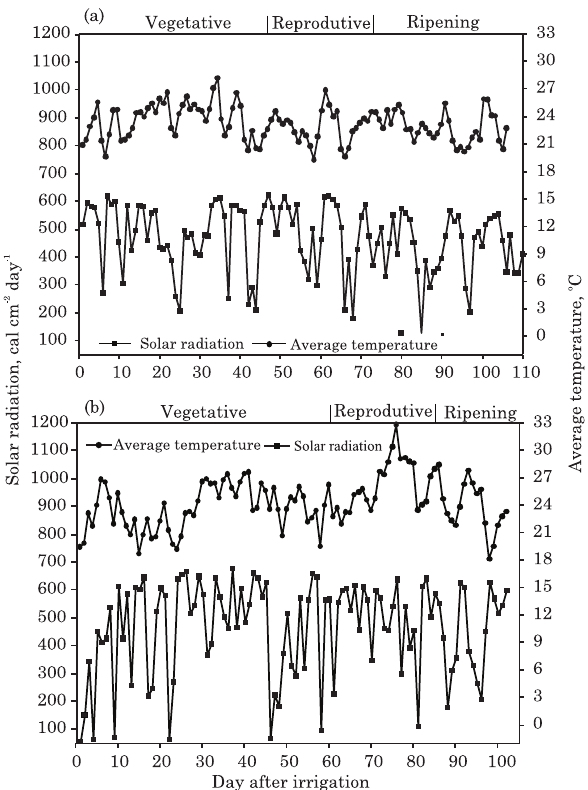
Figure 3. Average temperature and solar radiation during rice cycle in Santa Maria (RS,